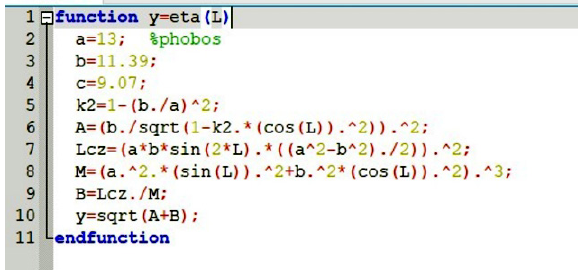
Fig. 5. The sub-integral